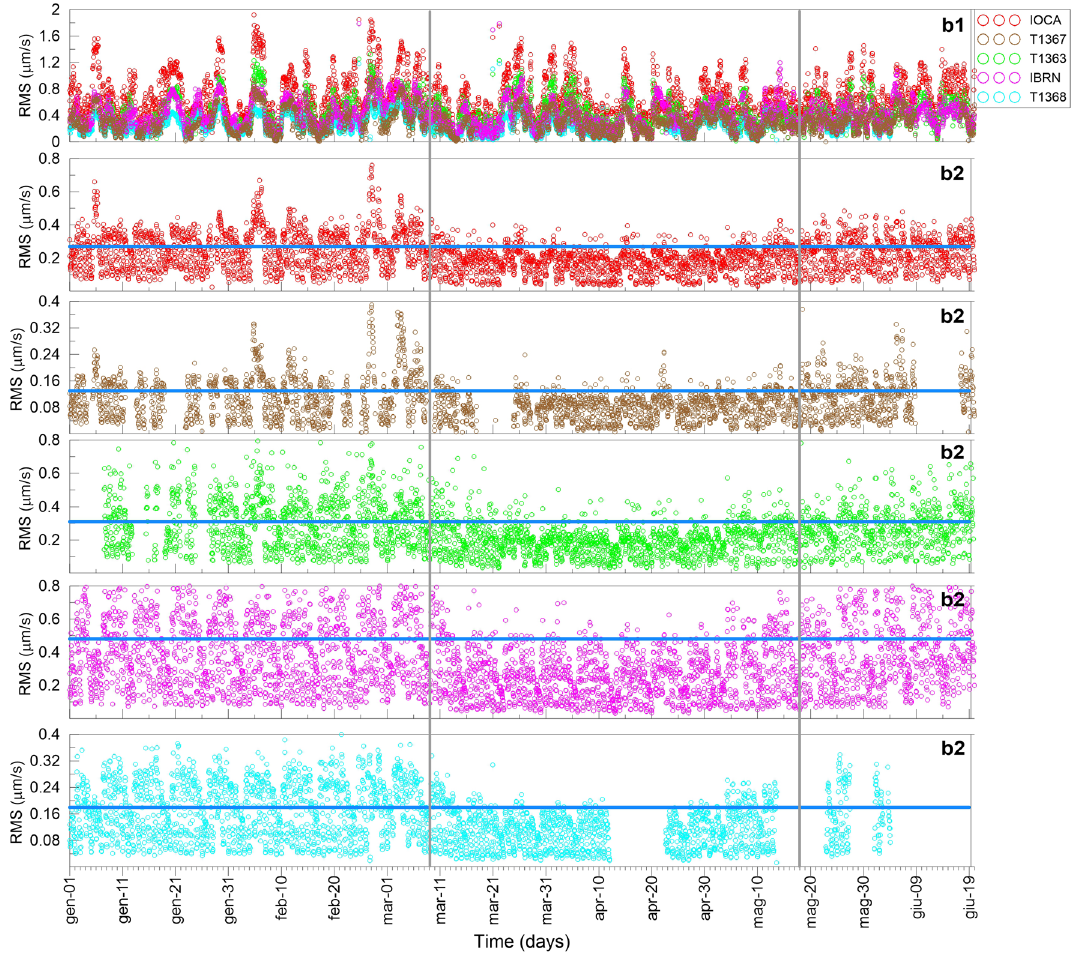
Figure 3. Time evolution of the RMS averaged over 1-h-long samples of the seismic noise recorded in the time interval January-June 2020. The upper panel shows the RMS in b1 for all the seismic stations. The RMS in b2 for each station is shown in the five remaining panels. Missing values are due to sensor breakdowns. The grey vertical lines indicate the beginning (March 9, 2020) of the lockdown and the end of the restriction measures (May 18, 2020); the blue horizontal line represents the 90 th percentile of the RMS distribution in the lockdown